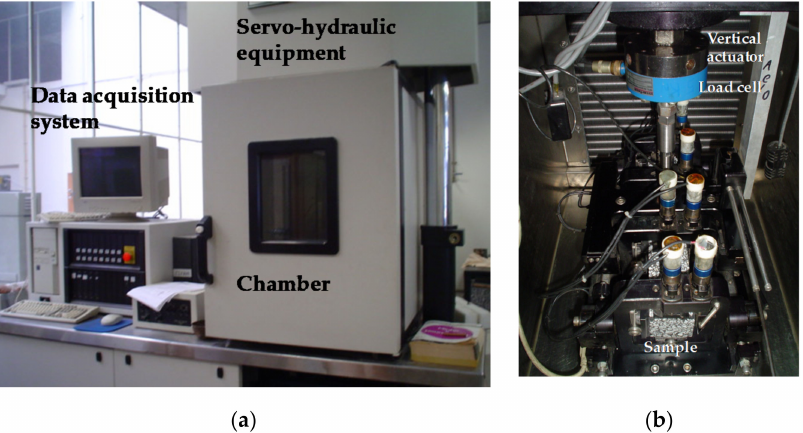
Figure 3. Servo-hydraulic equipment and four-point bending device test. ( a ) Servo-hydraulic equipment. ( b ) Four-point bending device